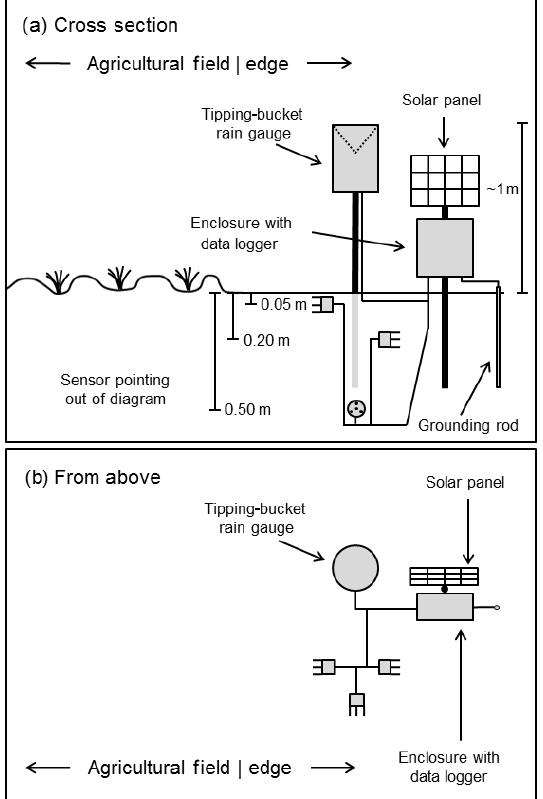
Figure 3. General configuration of three-probe soil moisture sta-